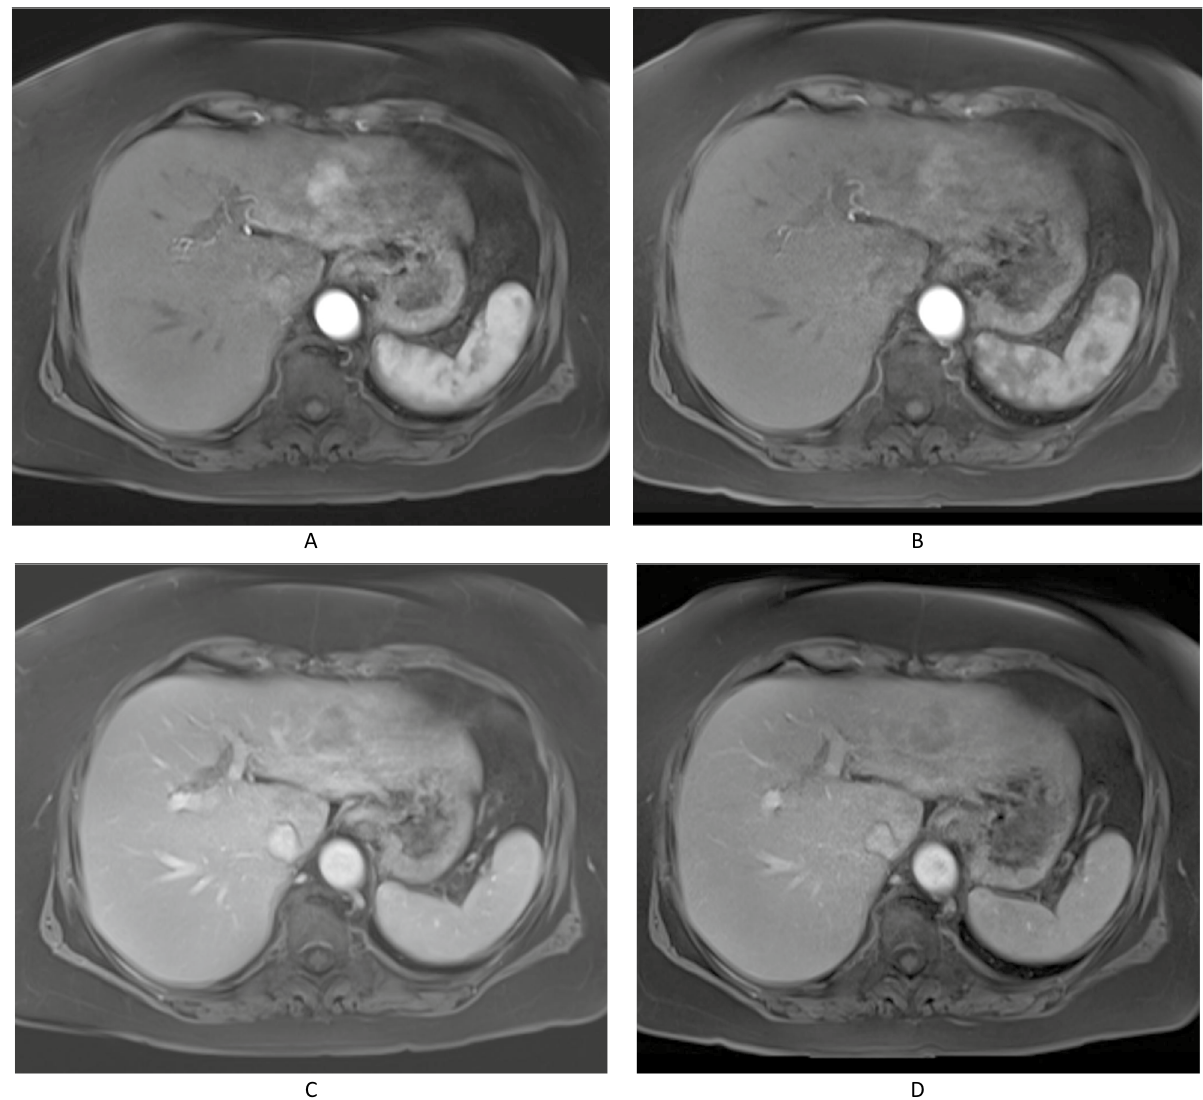
Figure 1. Wash-in and Wash-out dynamics of HCC lesions after administration of gadoteric acid and gadoxetic acid. Figures ( a,b ) demonstrates the stronger wash-in after administration of the extracellular contrast agent gadoteric acid ( a ) than with the hepatocyte-specific contrast agent gadoxetic acid ( b ). Figures ( c,d ) demonstrates the stronger wash-out following administration of gadoteric acid ( c ) than after gadoxetic acid ( d Major imaging features of LI‑RADS v2018.